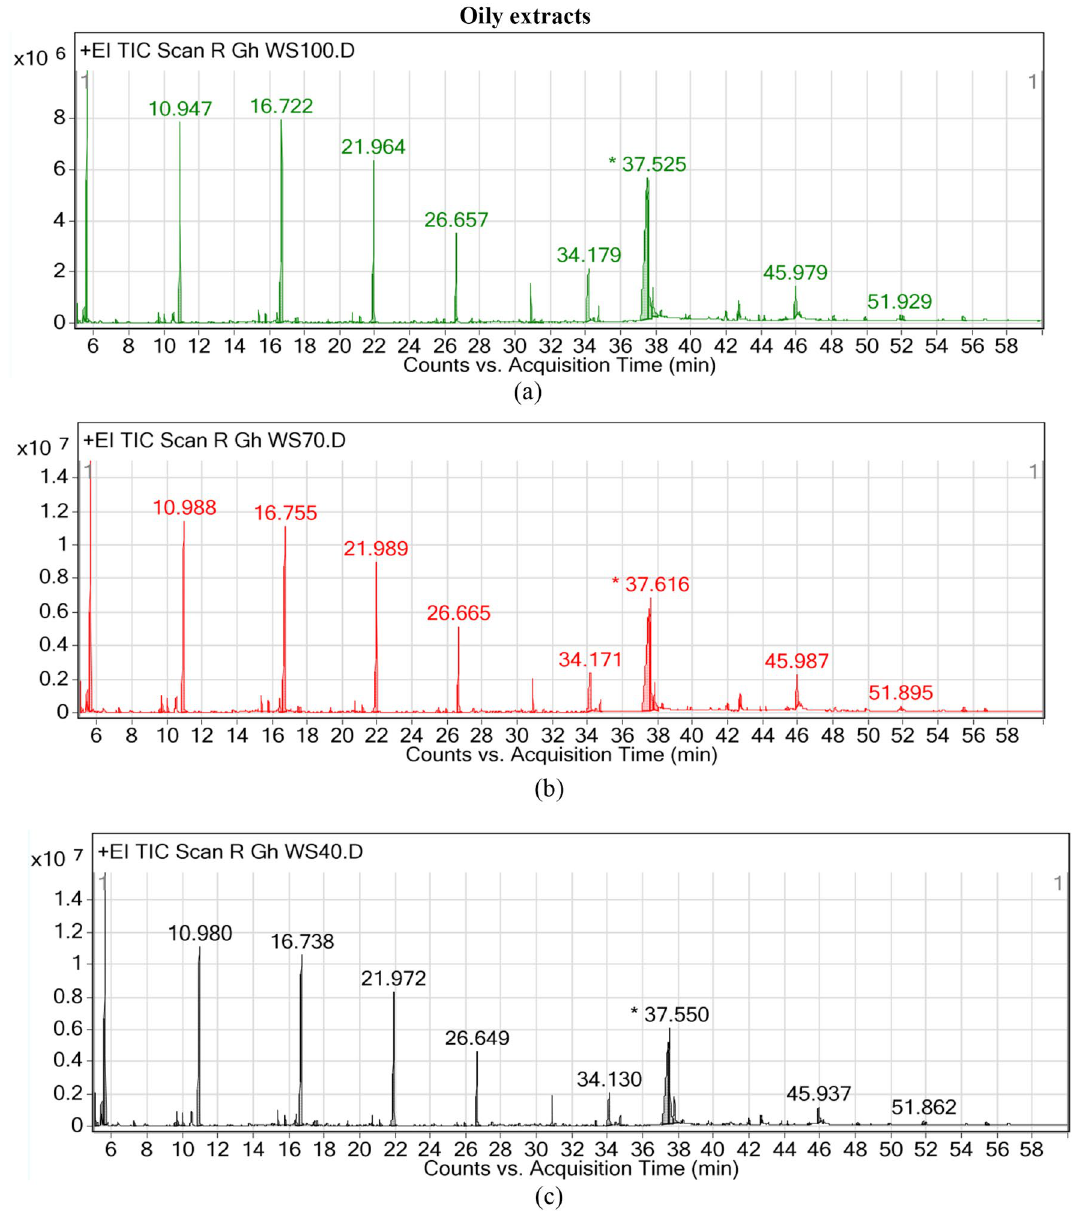
Figure 1. GC–MS peaks of oily extracts in milk thistle seeds under three different drought stress levels. ( a ) Field capacity: 100% FC, ( b ) 70% FC, ( c ) 40%